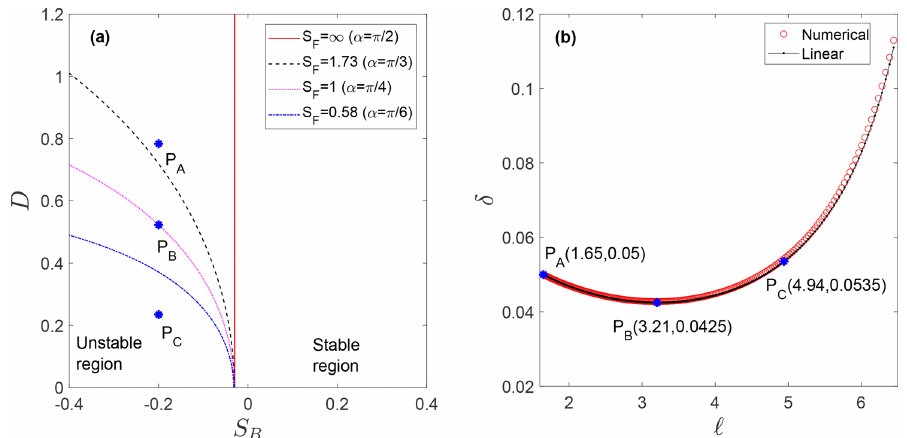
Figure 3. (a) The stability region of the absolute criterion for different foreset slopes S F with k = 1 and S T = 0 . 03. When S F = 1, the point P A is in a stable region, the point P B is on a boundary between the stable and unstable region, and point P C is in an unstable region. (b) The amplitude of the shape perturbation δ as a function of bulk shoreline position (cid:96) , in the case where the initial t = 0 shape of the shoreline is x ( t = 0) = 1 . 65 + 0 . 05cos( y ) and the foreset slope is S F = 1, and there is a linear variation (0 . 95 − 0 . 2( x − 1 . 6)m) of the water